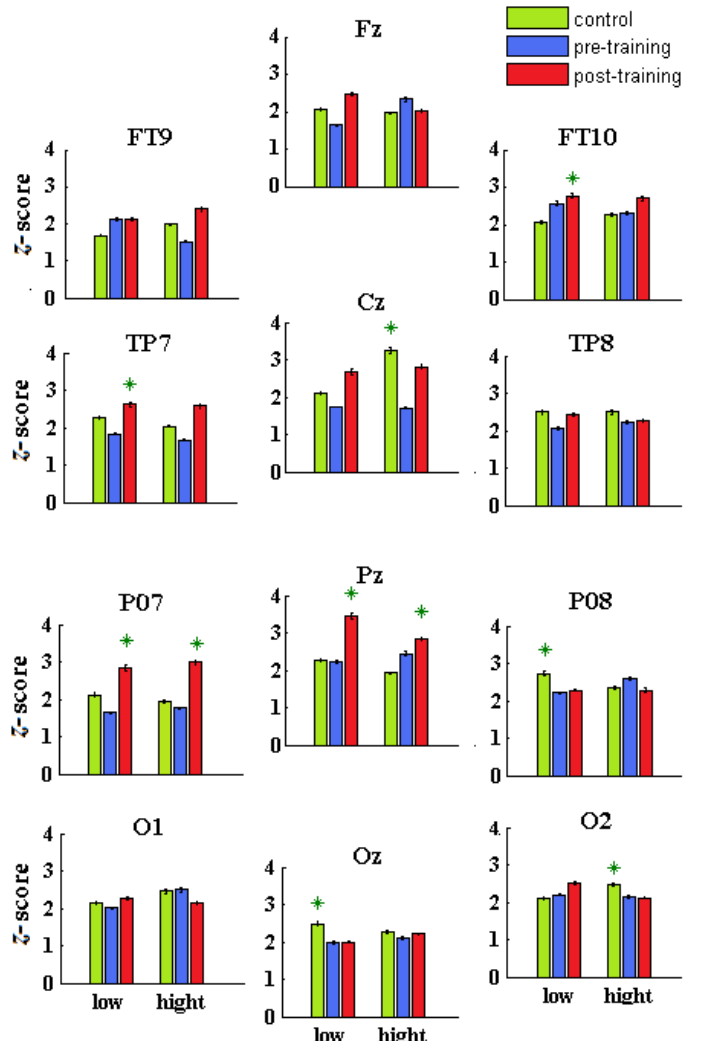
Figure 7. Averaged α / θ scores for each sensor and group (Con = green; preD = blue; postD = red) and condition (low and high contrast). The stars marked the highest values of α / θ scores across sensors, groups, and conditions. The sensor statistics for the postD group (vs. Con) yielded significantly higher α/θ scores at the SPL, left MOG, the MFG (low contrast: Pz and PO7; high contrast: Fz) and lower α / θ scores at the right middle occipital cortex (high contrast: PO8 -O2). The middle temporal, lateral occipitotemporal, dorsal associative visual, and occipital areas in the post- training children with DD contributed to the compensatory α and θ mechanisms, reducing right-hemispheric dominance over the left. The intra- hemispheric α / θ scores significantly increased at the middle temporal and occipital cortices (both conditions: TP7 and PO7) and the middle frontal, precentral, and superior parietal cortices (low contrast: Fz, Cz, and Pz) for the post-training group (vs. Con and preD). 5. Discussion The proposed EEG system design, which is easily scalable and adaptable to various EEG tasks, explored the α / θ z -NF effects during discrimination of different contrast LSF illusions on children with DD.